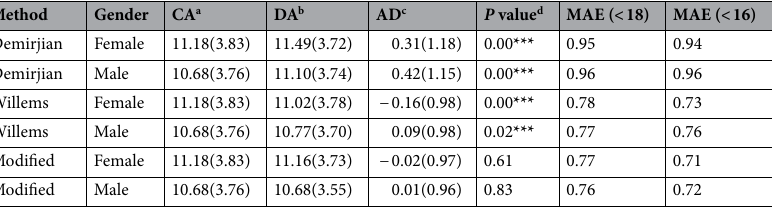
Table 2. The fitting effect of different models. MAE Mean absolute error. a Chronological age. b Dental age. c Age deviation, AD = dental age–chronological age. Chronological age, dental age and the age deviation are given as the mean (standard deviation). d Paired T test significance of chronological age and dental age.